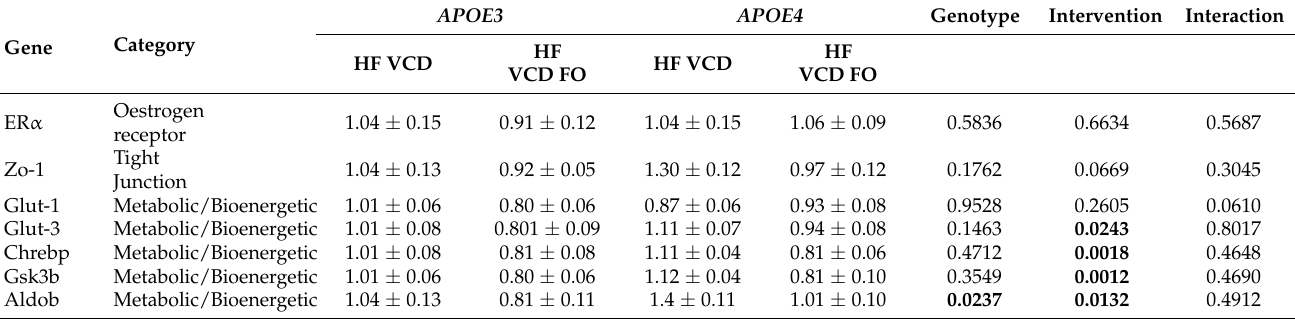
Table 2. RT-qPCR analysis of key bioenergetic and blood–brain barrier related genes in the